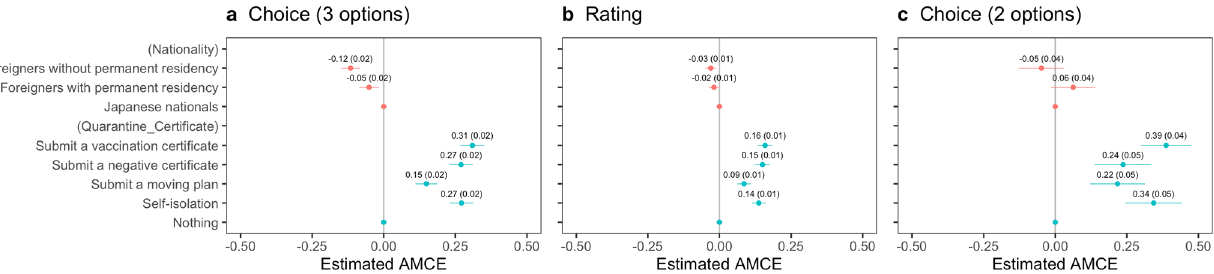
Using the fi rst score by factor analysis (see Supplementary Table 2), we divided respondents into “ High ” ( n = 534) for those who scored higher than or equal to the median and “ Low ” ( n = 532) for those who scored lower than the median.